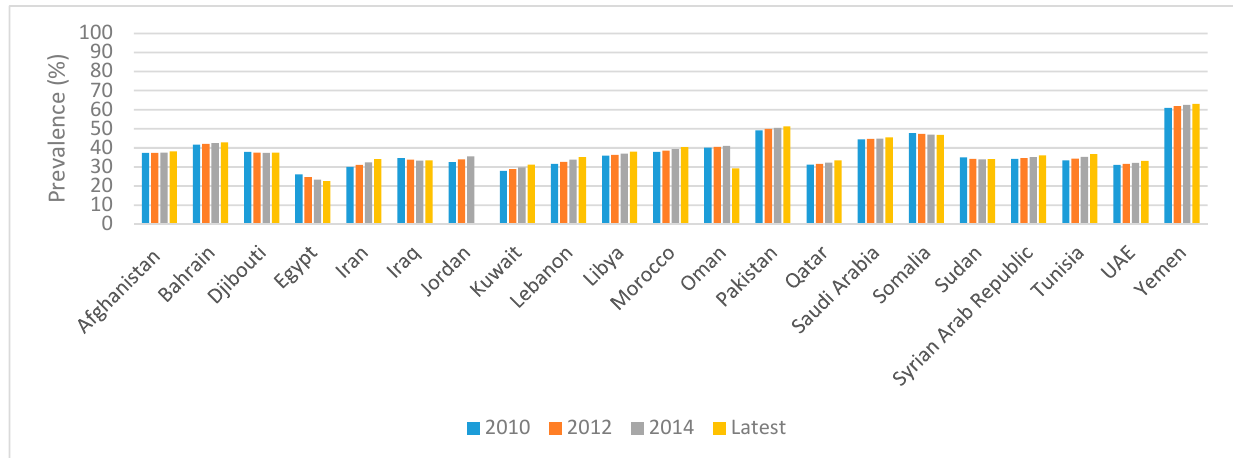
Figure 2. Trends in the prevalence of anemia amongst PW in countries of the EMR. References: The 2010, 2012, and 2014 data were based on the WHO GHO Database [27]. The latest data were also based on the 2016 WHO GHO Database [27], with the exception of the data pertinent to Oman, which were based on the recent Oman NNS 2017 [36]. Anemia was defined as an Hb concentration <110 g/L, adjusted for altitude and smoking. Abbreviations: EMR: Eastern Mediterranean Region; GHO: Global Health Observatory; Hb: hemoglobin; NNS: National Nutrition Survey; PW: pregnant women; UAE: United Arab Emirates; WHO: World Health